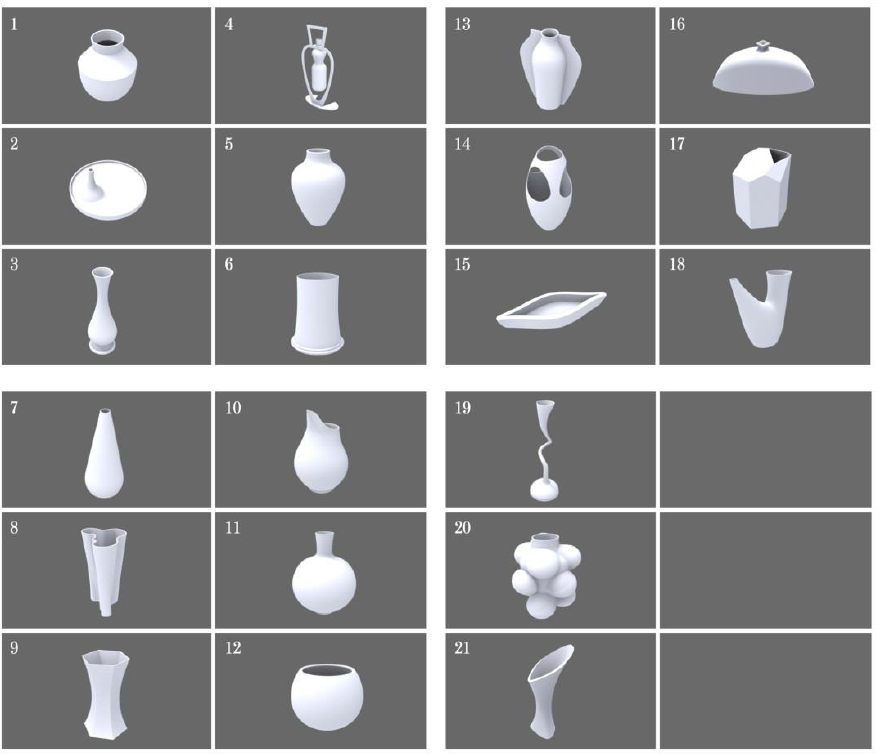
Figure 5. Questionnaire attachment of product samples.